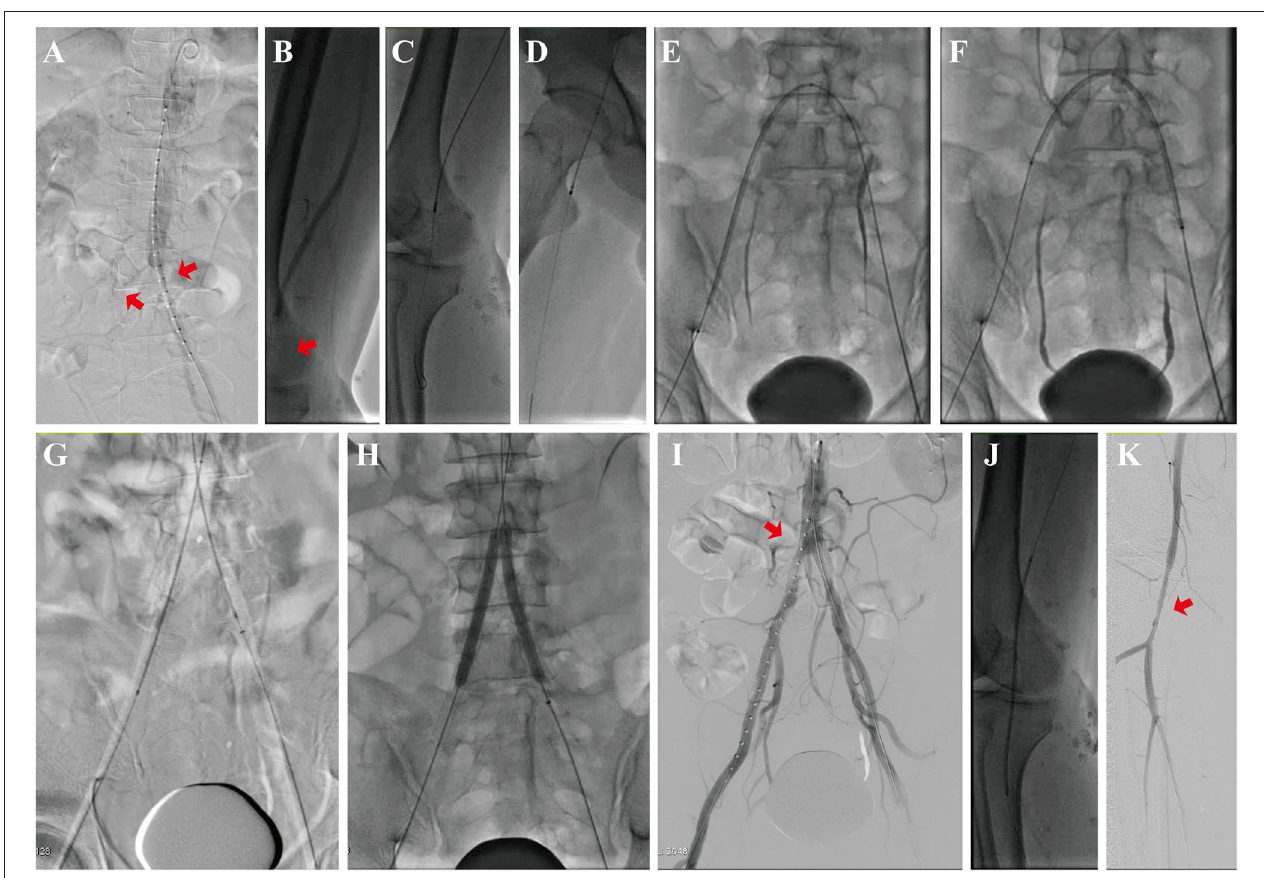
FIGURE 2 | Mechanical thrombectomy process by using the Rotarex® catheter for AASE treatment. (A) Emergency DSA shows occlusion of the distal aorta (red arrow) and bilateral common iliac artery. (B) Angiography shows occlusion of the right popliteal artery (red arrow). (C) Mechanical thrombectomy of the right popliteal artery. (D) Mechanical thrombectomy of the bilateral common iliac artery. (E) Balloon dilatation of the right iliac artery. (F) Balloon dilatation of the left iliac artery. (G) Kiss stenting of the bilateral common iliac artery. (H) Balloon dilatation of the bilateral common iliac artery. (I) Angiography shows the patency of the bilateral common iliac arteries (red arrow). (J) Balloon dilatation of the right popliteal artery. (K) Angiography shows the patency of the right popliteal artery (red